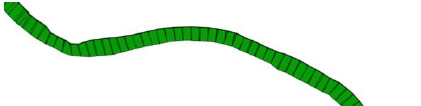
Figure 11. IFC roadway detail: alignment and